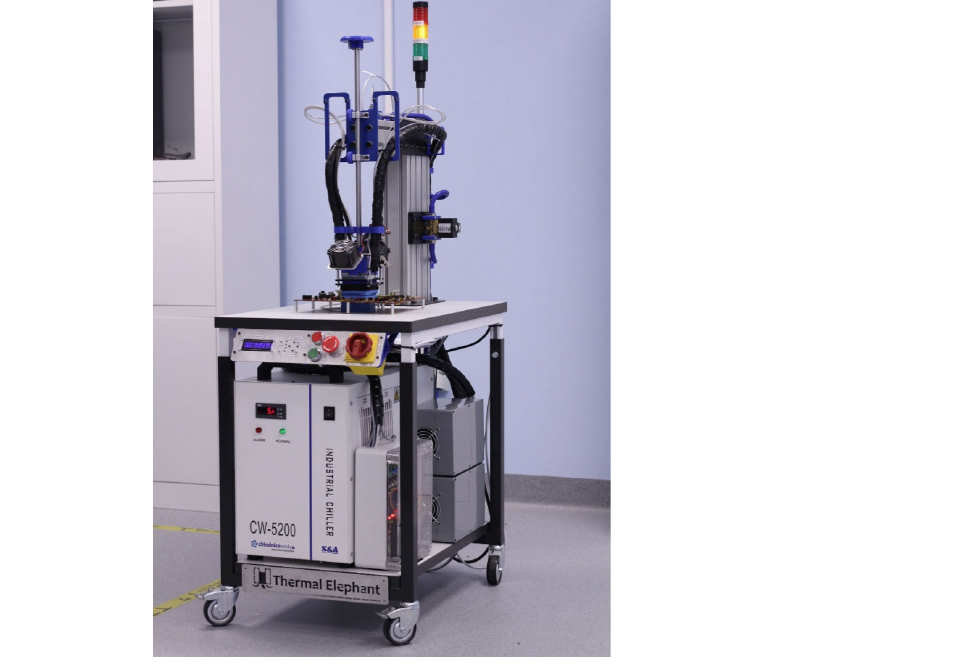
Figure 10. Photo of the Silicon Creations Thermal Elephant Unit for handling socket ‐ based testing systems.